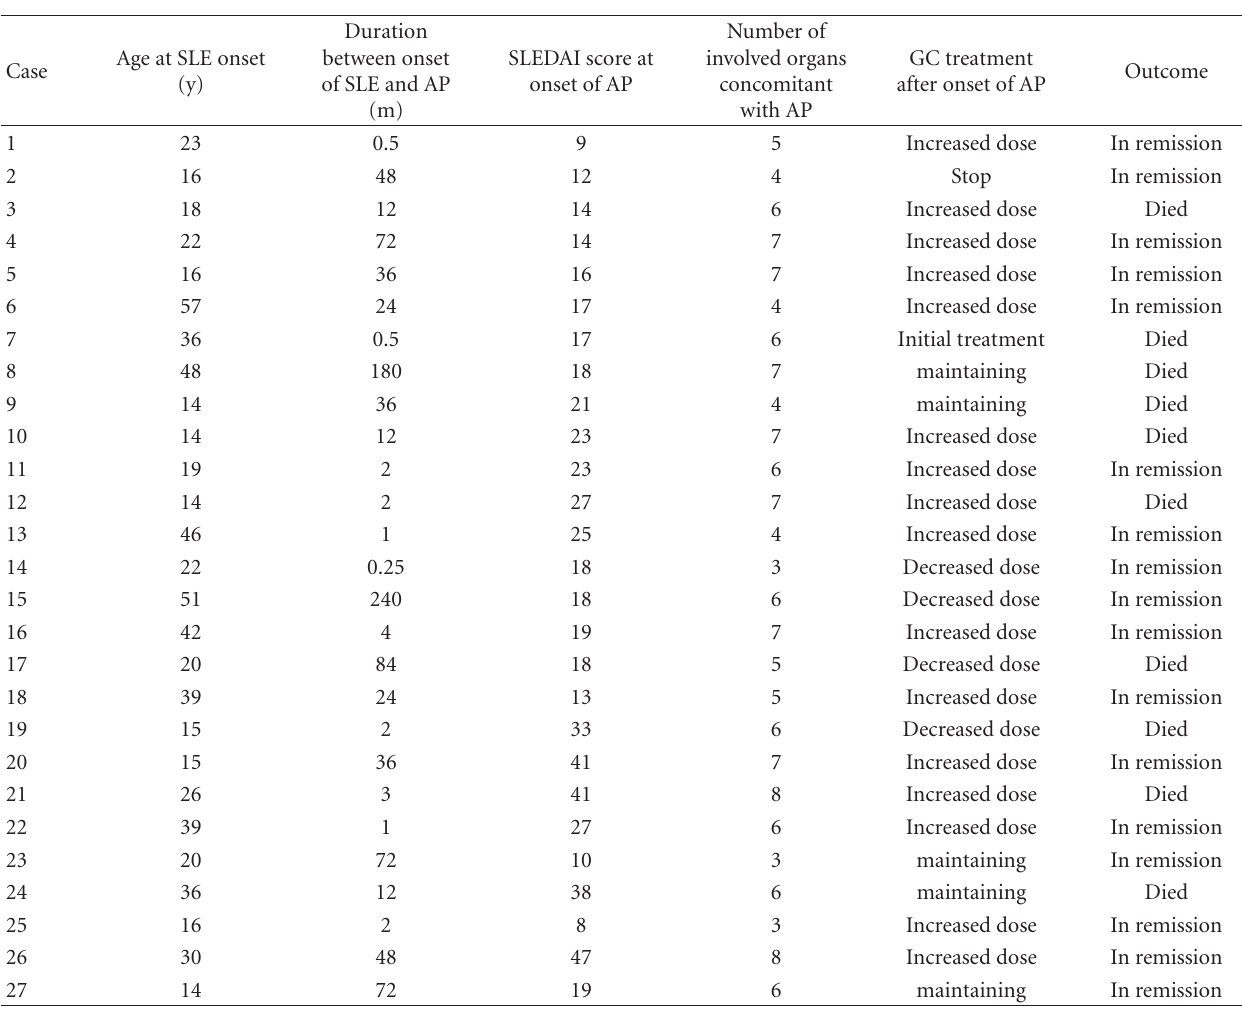
Table 1: The demographic and clinical characteristics of each SLE patient with AP.